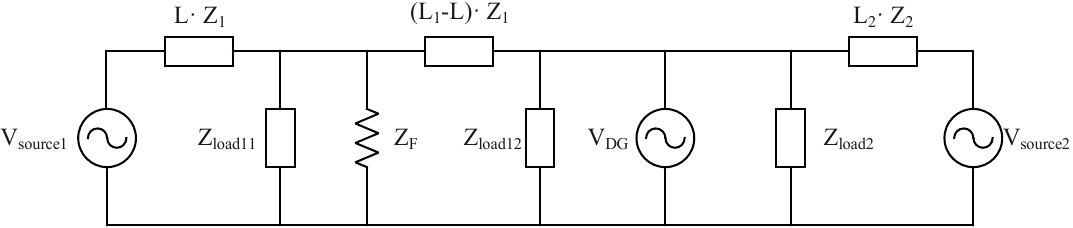
Figure 2. Equivalent circuit of loop distribution system.